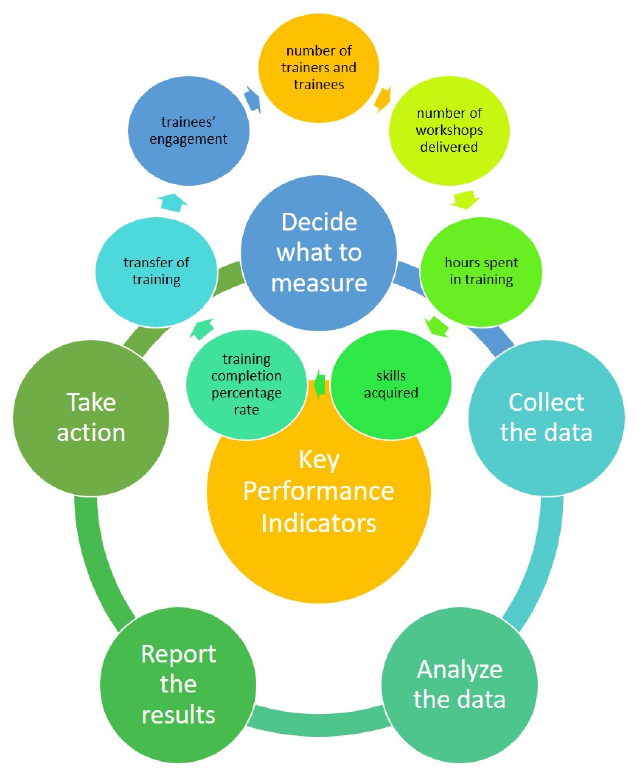
Figure 3. The 5 steps in applying KPIs, from the stage of deciding what to measure to the stage of taking action, and suggested KPIs for the WinSTONE training program.